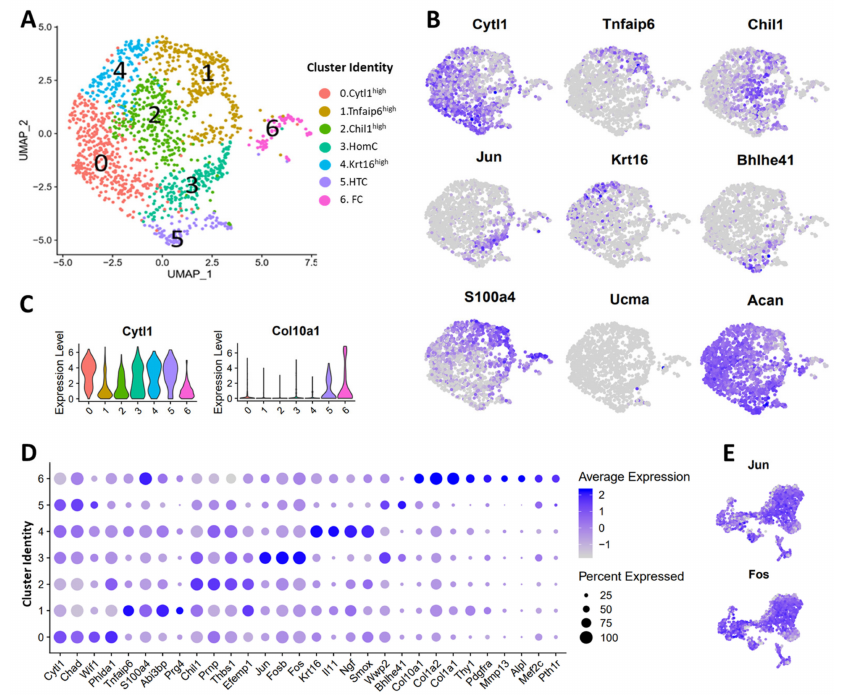
Figure 5. Comparison of human and mouse articular chondrocytes. ( A ) UMAP plots of various chon- drocyte subtypes in human osteoarthritic knee joints. Colors indicate clusters of various cell types with distinct gene expression profiles. ( B ) Feature plots showing the expression of key chondrocyte markers in human chondrocytes. Blue: high expression, grey: low expression. ( C ) Violin plot show- ing the expression of Cytl1 and Col10a1 in human chondrocyte subtypes. ( D ) Dot plot showing the expression of selected markers of various clusters. Dot size represents the fraction of cells expressing a specific marker in a particular cluster and intensity of color indicates the average expression level in that cluster. ( E ) Feature plots showing the expression Jun and Fos in mouse